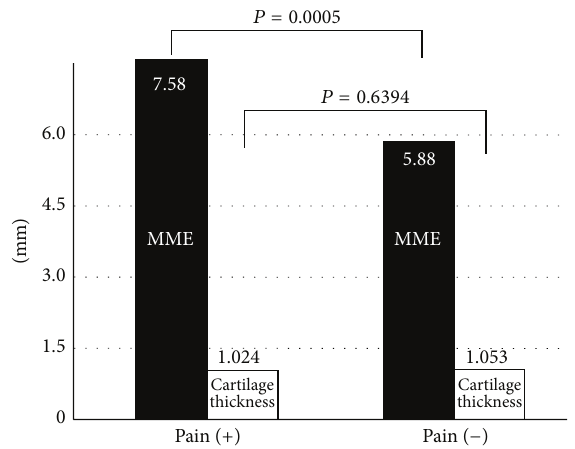
Figure2: Relationshipbetweenpainandmedialmeniscalextrusion or the cartilage thickness of the femoral medial condyle. The average cartilage thicknesses of the knees with and without pain were 1.02 and 1.05 mm, respectively, with no significant difference ( 𝑃 = 0.6394 ). The average medial meniscal extrusions (MMEs) of the knees with and without pain were 7.58 and 5.88 mm, respectively; knees with pain had greater MMEs than knees without pain ( 𝑃 = 0.0005